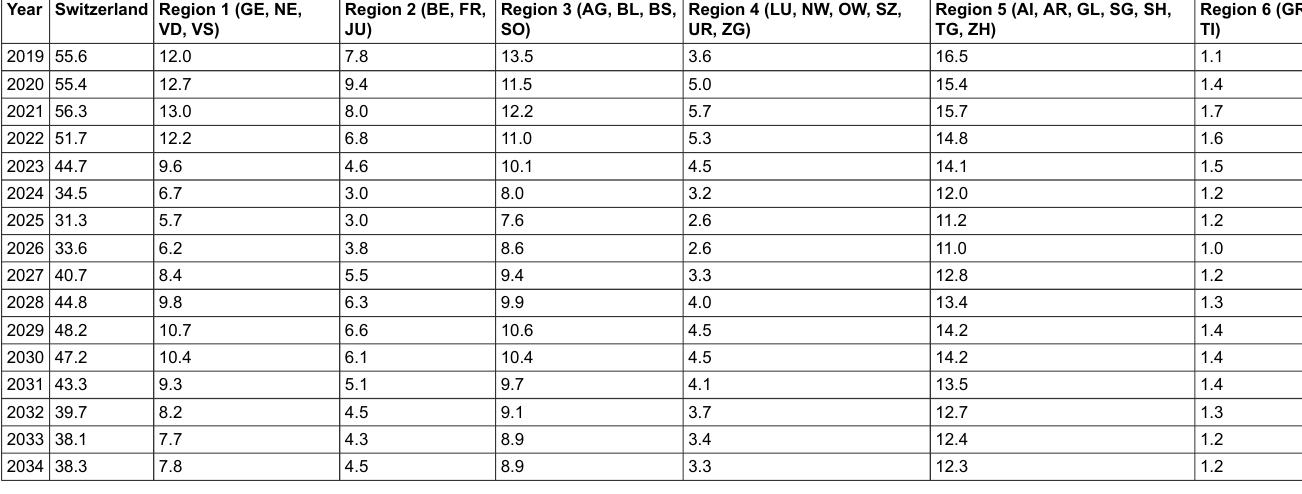
Table 5: Average number new trainees (FTE) to be recruited annually to maintain a constant number of trainees . Year Switzerland Region 1 (GE, NE, VD,